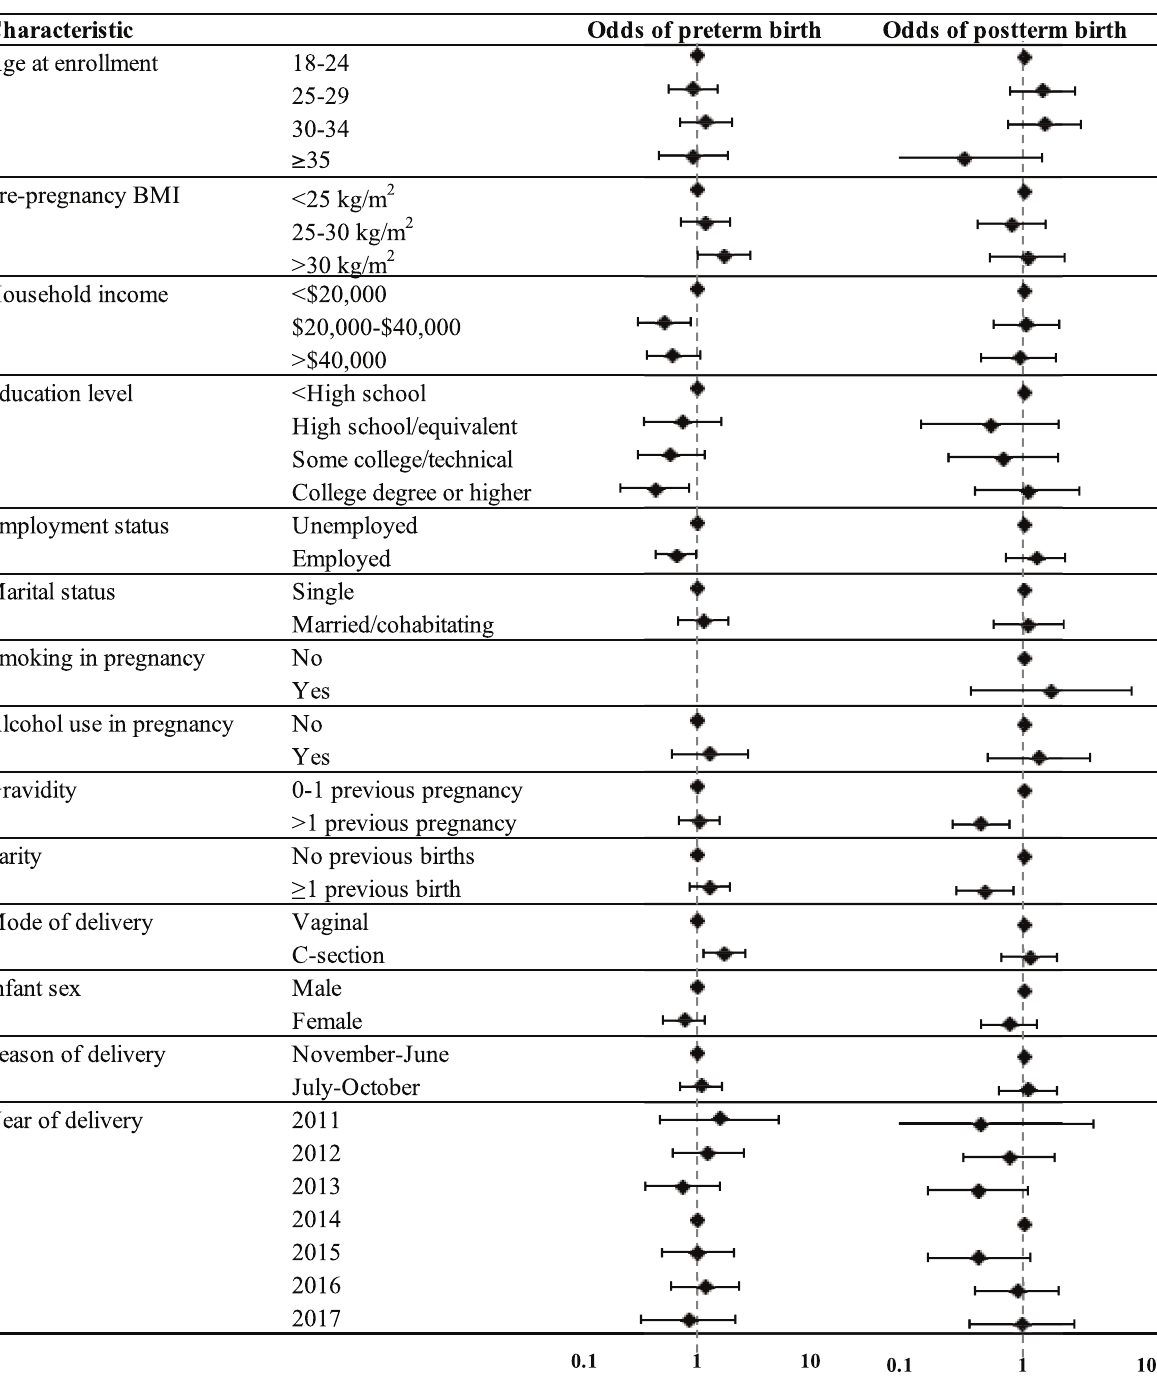
Fig 2. Odds ratios and 95% confidence intervals for preterm and postterm birth in association with demographic and pregnancy characteristics in the PROTECT cohort 2011–2017.